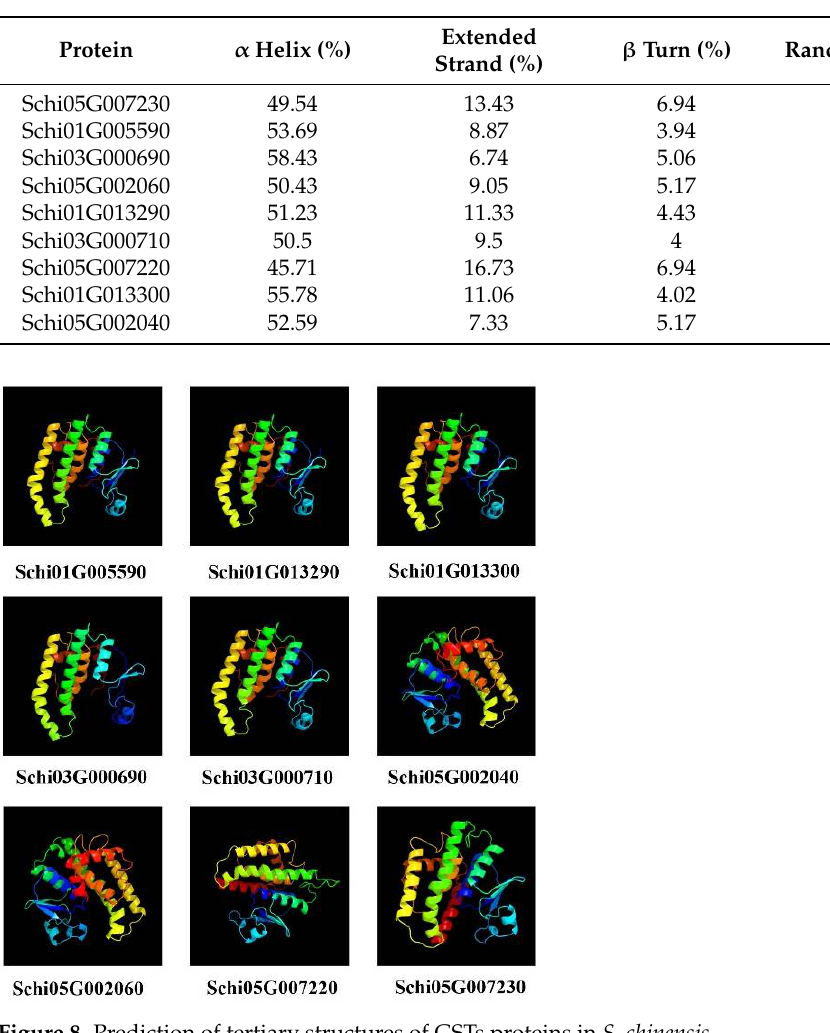
Table 5. Secondary structure of the GST gene family proteins in S. chinensis .